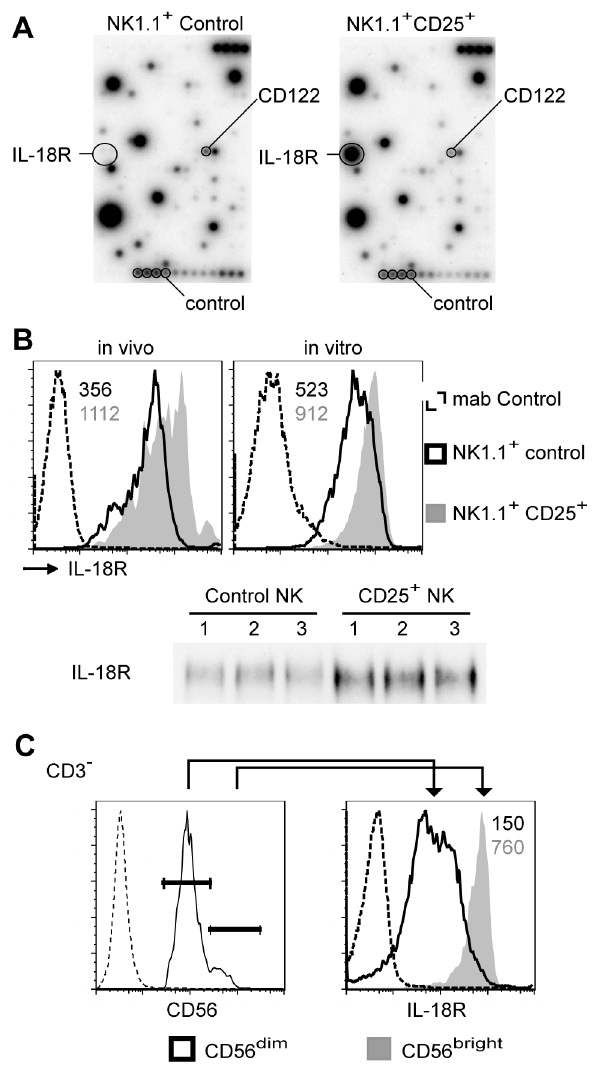
Figure 5. Post-activation NK cells express high levels of the IL- 18 receptor. Post-activation CD25-positive and control NK cells were expanded for 7 days in IL-2. An analysis of the expression of various cytokines, receptors and signaling molecules using a microchip revealed an increase of IL-18 receptor RNA levels. B. Cytometry analyses showed increased expressions of the IL-18 receptor in murine CD25 + NK cells either from B16-bearing mice (left) or after 6-h incubations with B16 and 0.2 nM IL-15SA (right) when compared with CD25 2 control NK cells. Numbers denote mean fluorescence intensities of the IL-18 receptor. An increase of IL-18 receptor protein levels was also observed when in vivo-activated, sorted and IL-2-expanded NK cells were compared with sorted and IL-2-expanded control NK cells by Western blotting. The corresponding b -actin control is shown in Fig. 2. C. Analyses of sorted human NK cells showed higher IL-18 receptor expression in CD3 2 /CD56 br ight when compared with CD3 2 /CD56 dim NK cells. Cytometry analyses were reproducible in three independent experiments. CD56 dim NK cells (5.1-fold increase of its mean fluorescence intensity). Thus, murine post-activation and human CD56 br ight NK cells show an up-regulation of the IL-18 receptor.